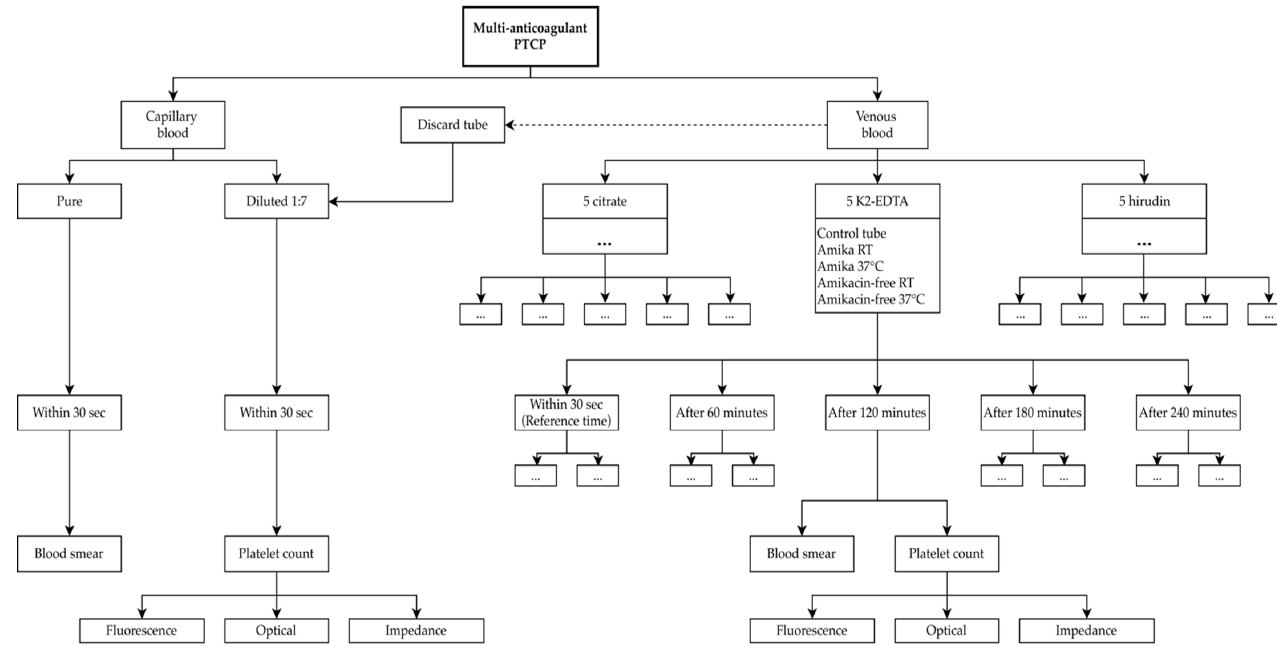
Figure 1. Study protocol. Empty boxes just repeat the same elements as adjacent boxes. The time is expressed in seconds or minutes after blood collection. Abbreviations: PTCP, Pseudothrombocytopenia; RT, room temperature; EDTA, ethylenediaminetetraacetic acid.